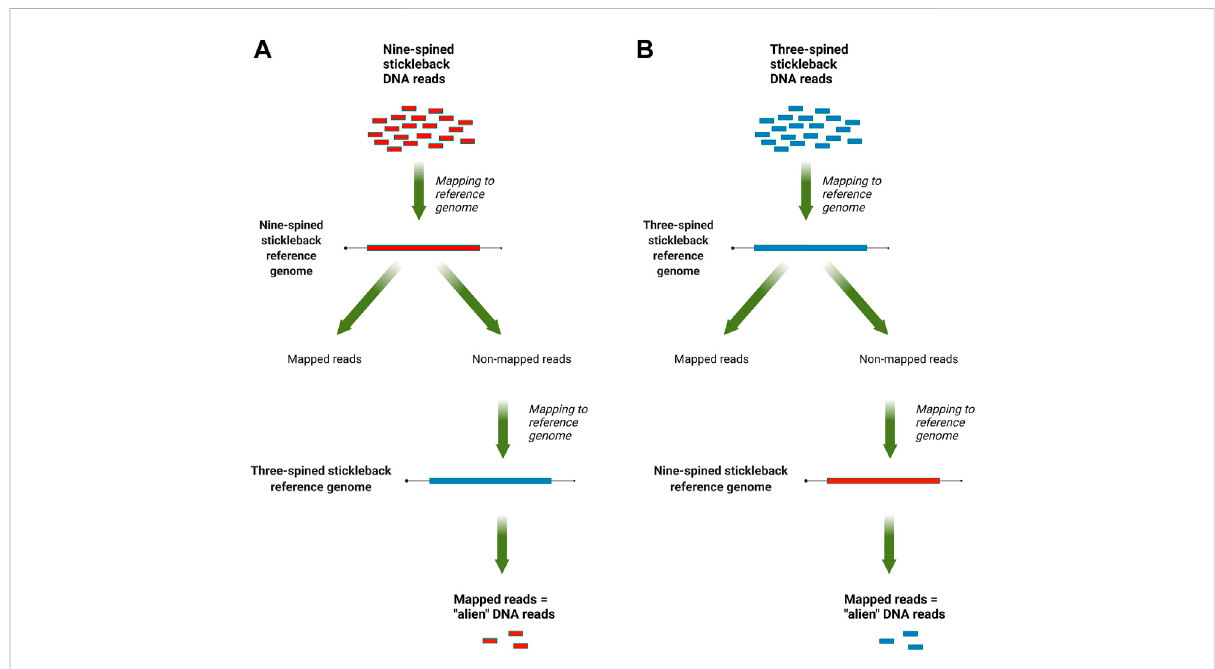
FIGURE 1 An overview of the “ alien ” read rate estimation pipeline: (A) for nine-stickleback sequencing data; (B) for three-spined stickleback sequencing